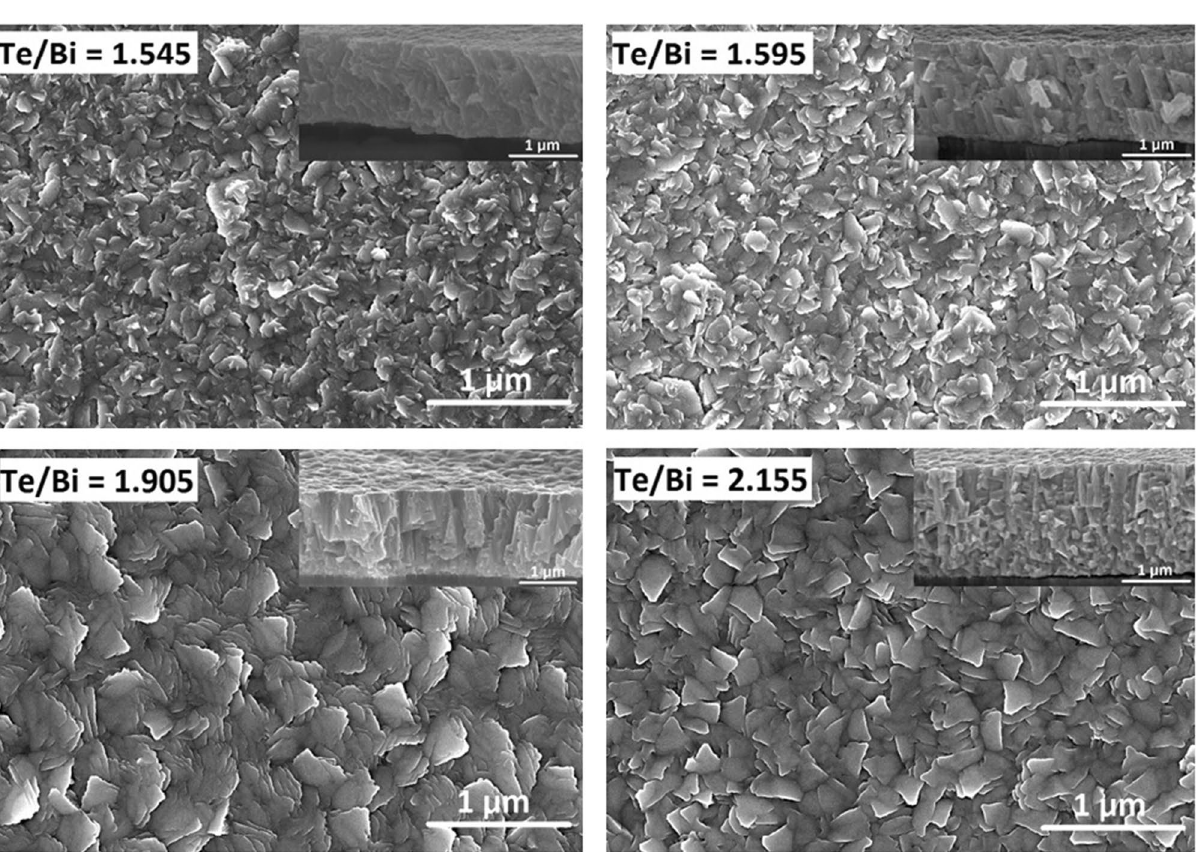
Figure 9. SEM images showing the surface and cross-sectional (inset) morphologies of the Bi–Te thin films after thermal